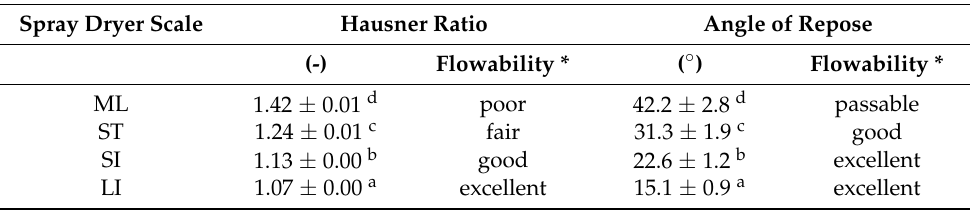
Figure 4. Loose and tapped bulk density of spray dried beetroot powder at different process scale (ML—mini-laboratory scale, ST—semi-technical scale, SI—small industrial scale, LI—large industrial scale; a, b, c, d—different letters show significant differences between spray dryer scale ( p ≤ 0.05)). Table 2. Characteristics of spray-dried beetroot powders flowability: mean ± standard deviation of three replications of Hausner ratio (HR) and angle of repose (AR).